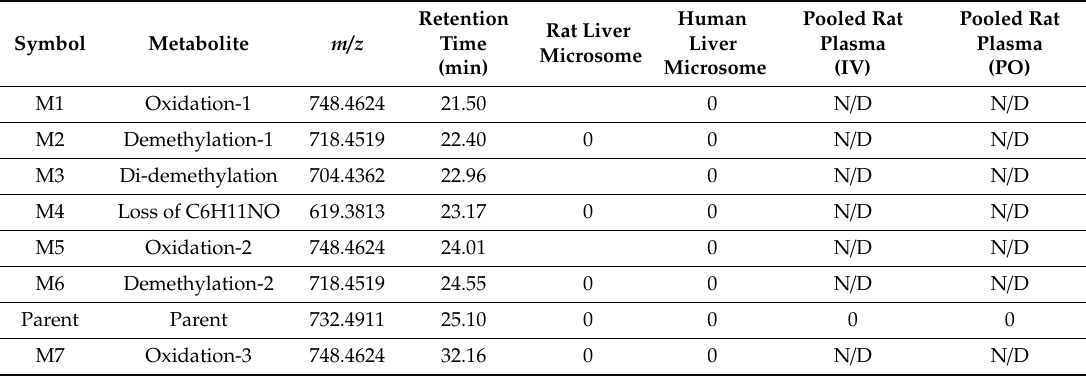
Table 7. Characterization of MMAF (monomethyl auristatin F) and its metabolites (error ppm ≤ 5